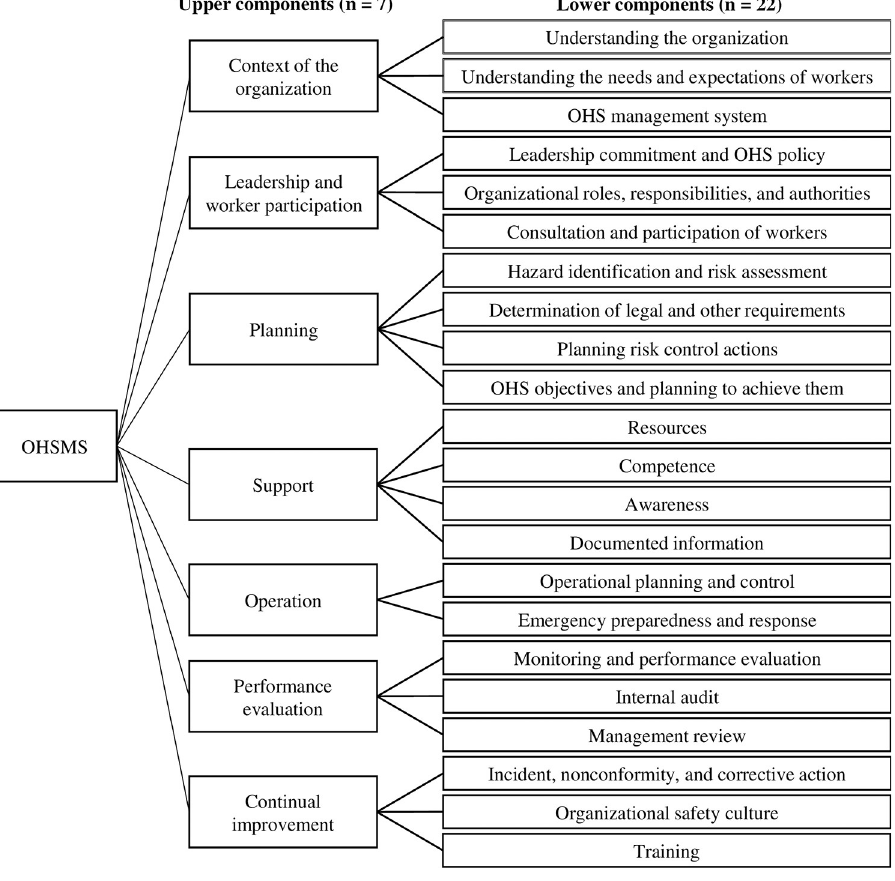
Fig 2. OHSMS standard